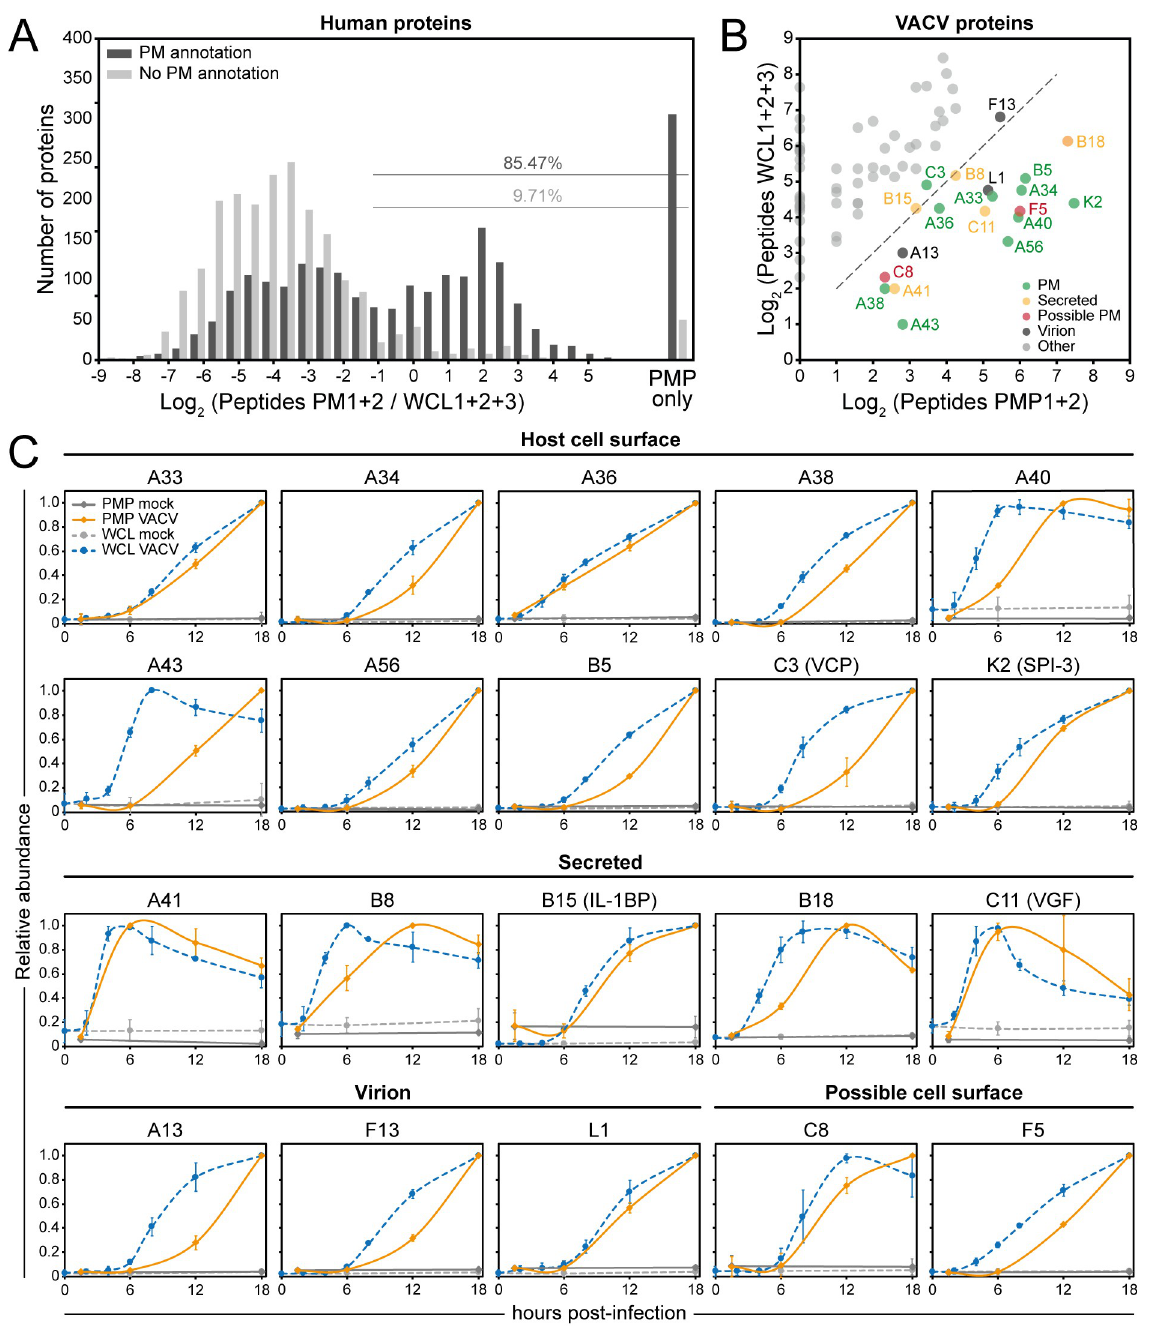
Fig 6. Identification of high-confidence VACV PM proteins. ( A ) Peptide ratios comparing the peptide count for a given protein in the PMP vs. WCL [9] for all human proteins quantified in both PMP replicates. ‘PMP only’ = not detected in any of the WCL replicates. ‘PM annotation’ includes GO terms PM, CS, XC and ShG. ( B ) Cut-off peptide ratio of 0.5 (dashed line), as determined in panel A, applied to 73 VACV proteins detected in either of the PMP replicates to identify high-confidence VACV PM proteins (Table 1). ( C ) Temporal profiles of all known and high-confidence VACV PM and secreted proteins. Data are represented as mean ± SD (PMP n = 2; WCL n = 3, A43: WCL n = 1).